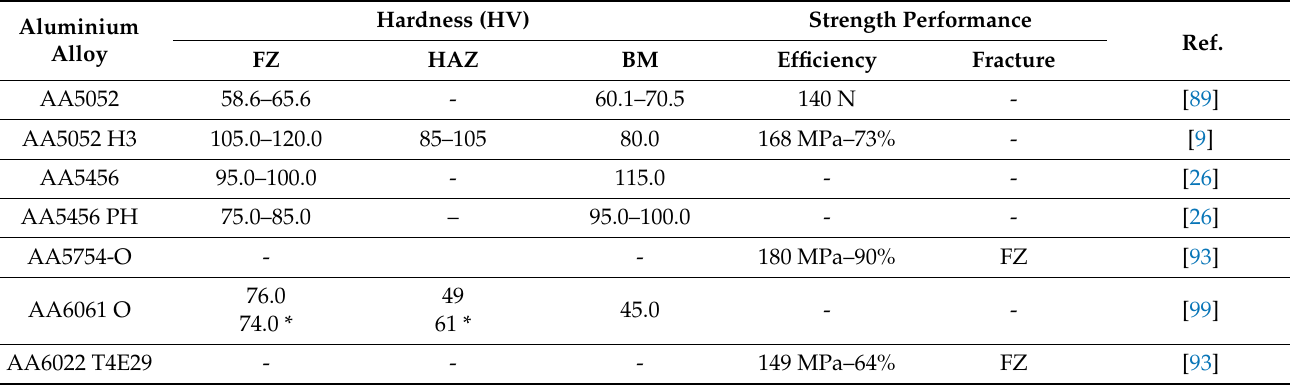
Table 6. Selected results of pulsed laser welding applied to similar aluminium alloys (approximated values).